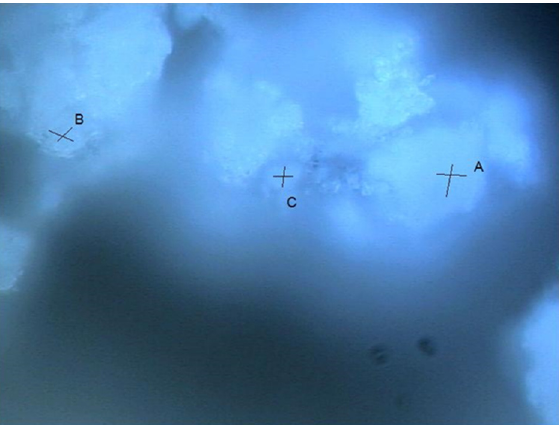
Figure 7. Light optical micrograph of selected testing area and points (A–C) from the sulfate-attacked SF–PC sample.